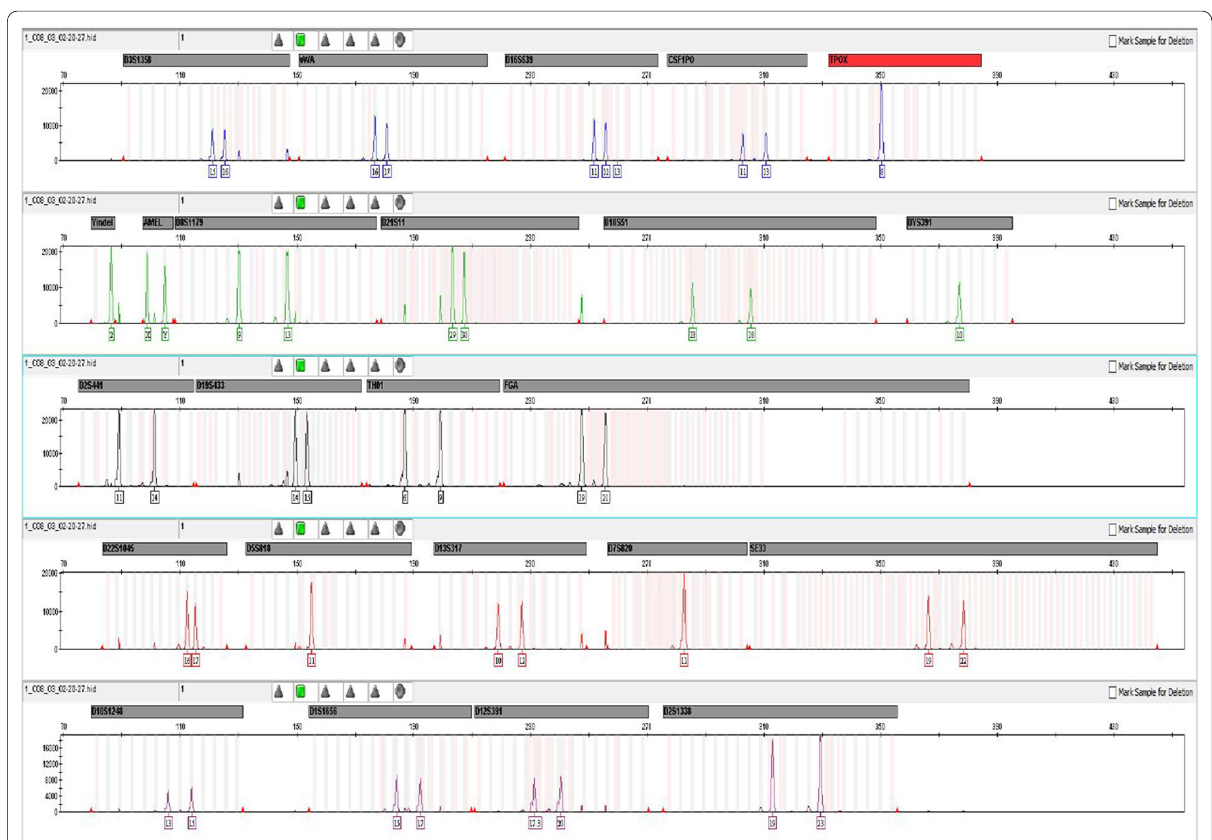
Fig. 4 Full profile of donor obtained from the whole blood